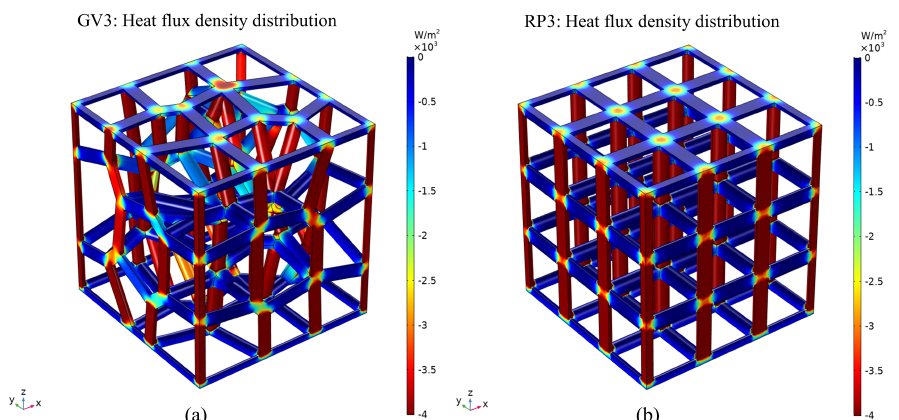
Figure 13. Heat flux density distribution of porous materials of different structural types with 89% porosity: ( a ) GV3; ( b ) RP3.